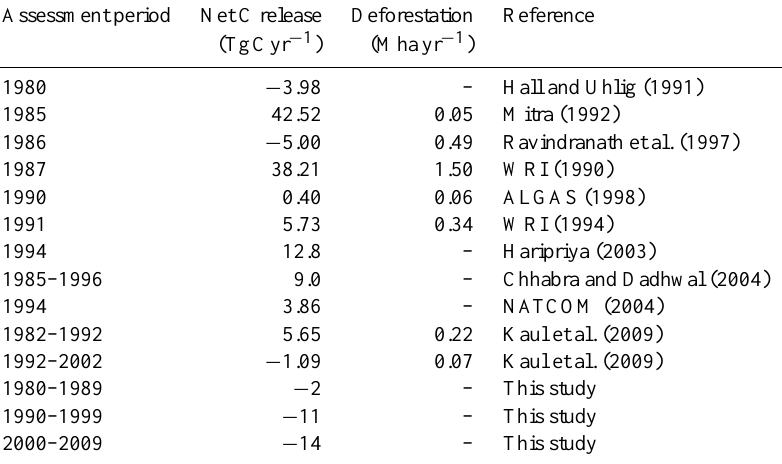
Table 3. Estimates of carbon emissions ( + ) and removals ( − ) from land-use change in India (from Kaul et al.,